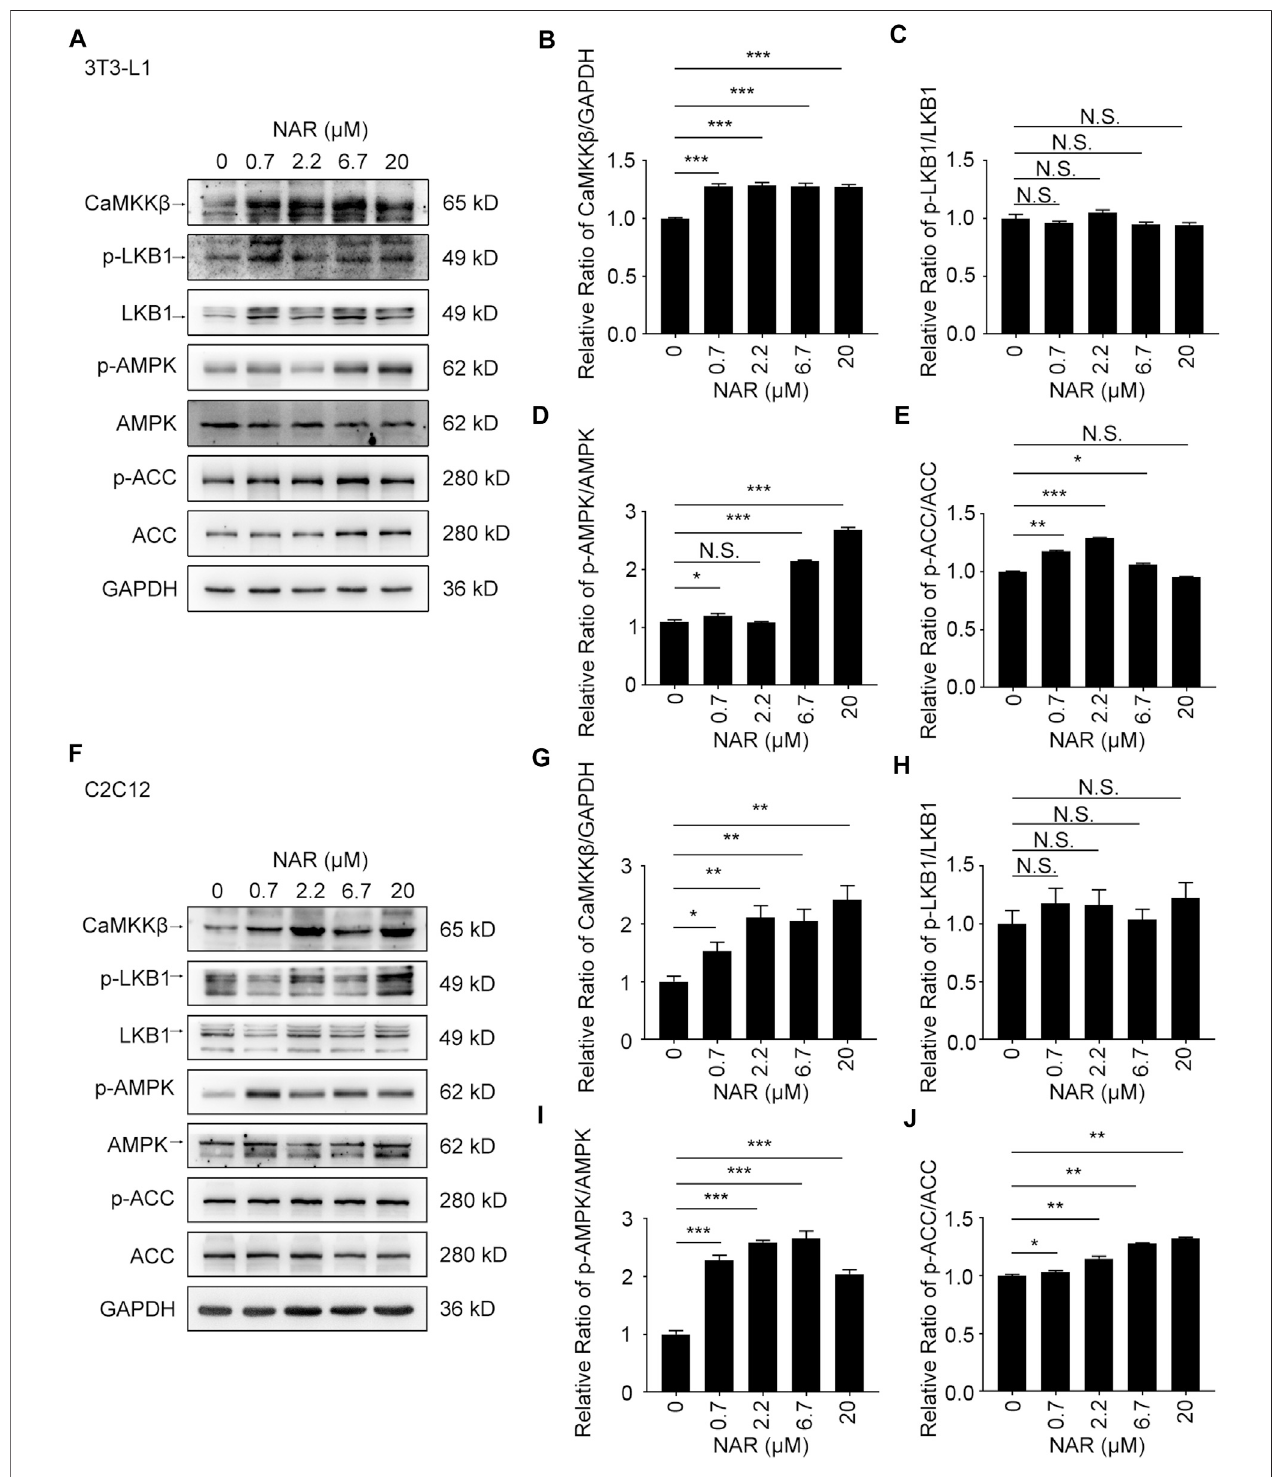
FIGURE 3 | NAR activates the CaMKK β /AMPK/ACC pathway in 3T3-L1 adipocytes and C2C12 myotubes. The expressions of CaMKK β , p-LKB1, LKB1, p-AMPK,AMPK,p-ACC,and ACC of3T3-L1adipocytes (A – E) and C2C12 myotubes (F – J) after treatmentofNARwere measured byWesternblotting. Allvalues were expressed as the mean ± SD from three or more independent experiments. *** p < 0.001; ** p < 0.01; * p < 0.05 vs . untreated cells.; Abbreviation: NAR, naringenin; CaMKK β , calmodulin-dependent protein kinase β ; LKB1, liver kinase B1; p-LKB1, phosphor-LKB1; AMPK, AMP-activated protein kinase; p-AMPK, phosphor- AMPK; ACC, acetyl-CoA carboxylase 1; p-ACC, phosphor-ACC.